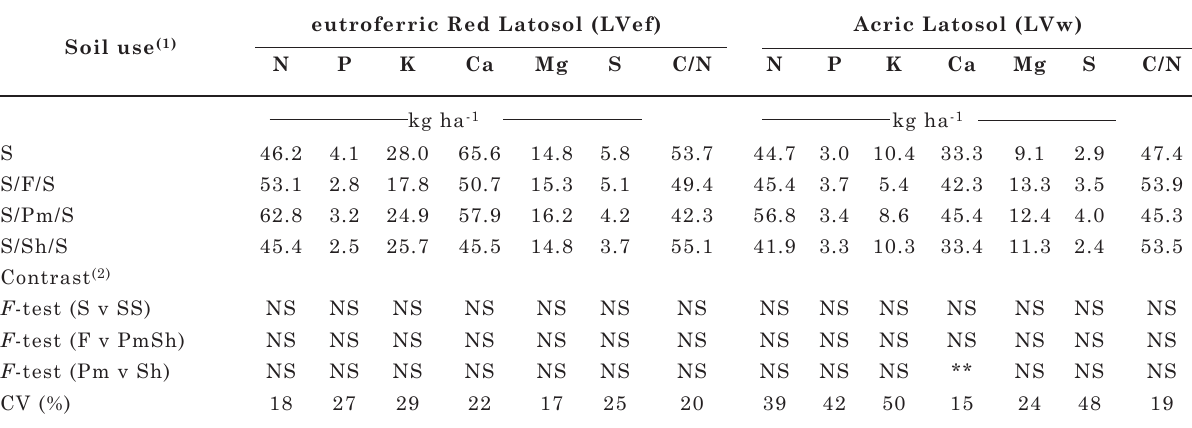
table 6. residue nutrient accumulation and c/n ratio after the grain harvest in march 2010 and significance of the contrasts